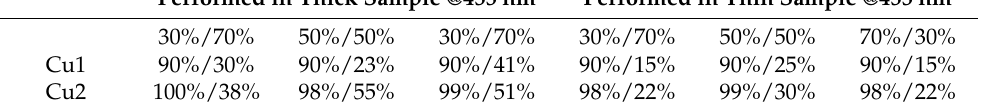
Table 5. Final conversions of acrylate and epoxides functions for the IPN synthesis of TA/EPOX blend using Cu1 (or Cu2)/Iod/NPG (0.1%/1%/1%/ w / w / w ) as PIS upon exposure to visible light at 455 nm.